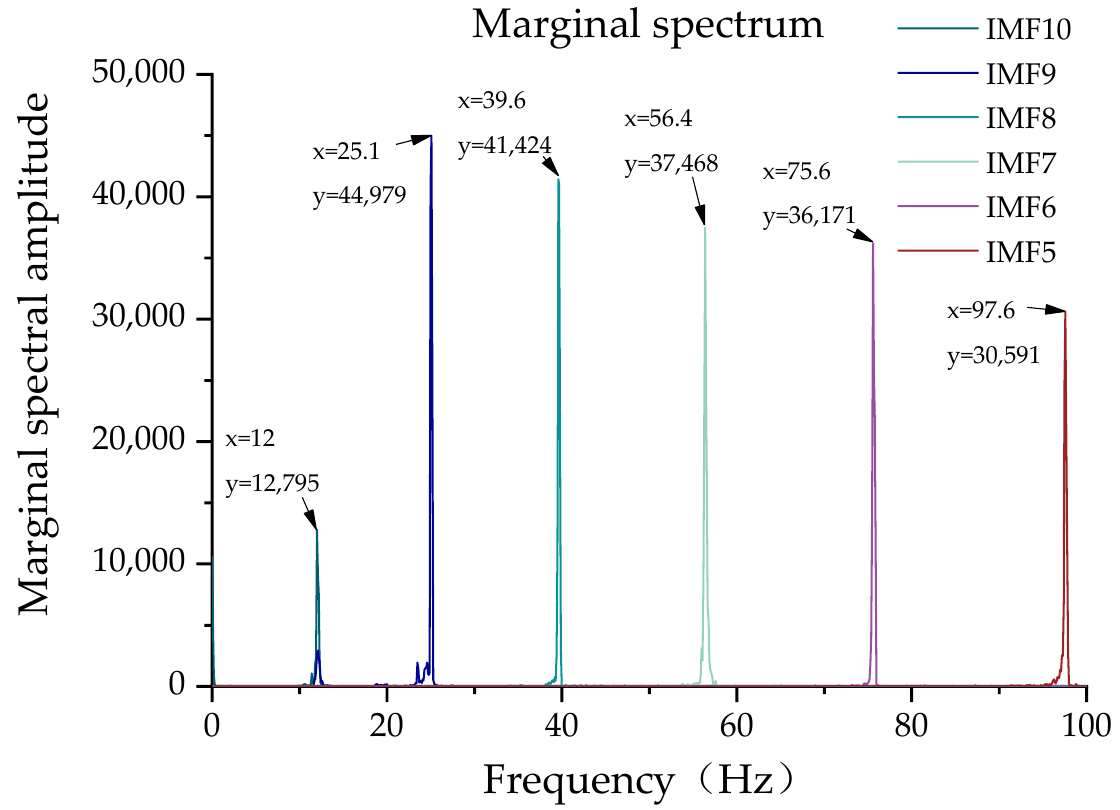
Figure 9. Marginal spectrum of IMF5~IMF10.